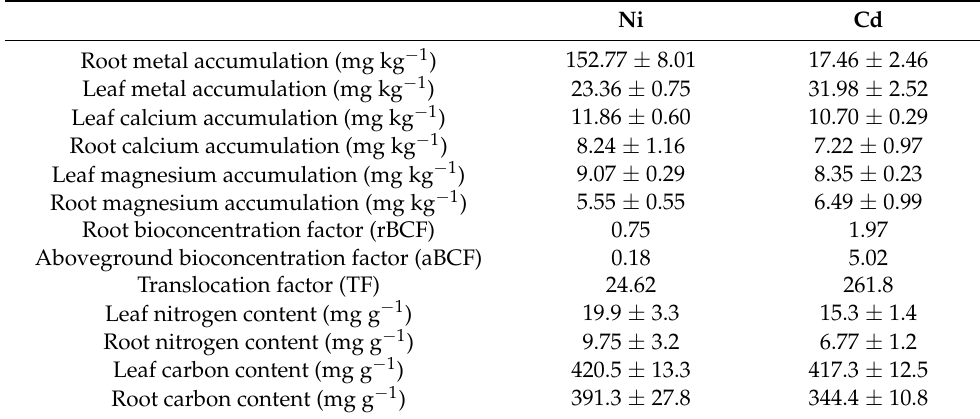
Table 1. Metal and non-metal accumulation (mean ± SD), bioconcentration, and translocation factors of Ni and Cd in P. deltoides clone